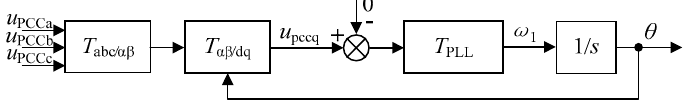
Figure 2. The diagram of PLL